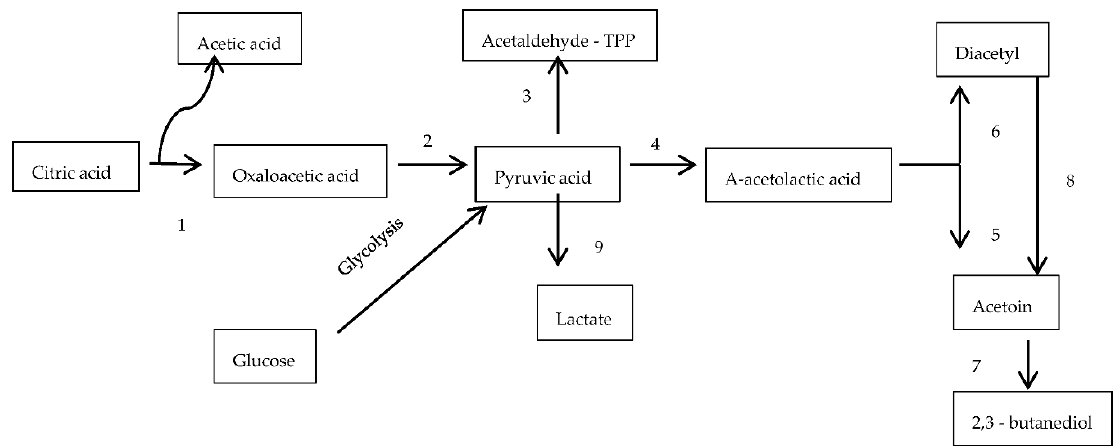
Figure 4. Simplified metabolism of citric acid by O. oeni . 1, citrate lyase; 2, oxaloacetate decarboxylase; 3, pyruvate decarboxylase; 4, α -acetolactate synthase; 5, α -acetolactate decarboxylase; 6, non-enzymatic oxidative decarboxylation; 7, acetoin reductase; 8, diacetyl reductase; 9, lactate dehydrogenase and TPP, thiamine pyrophosphate [11].